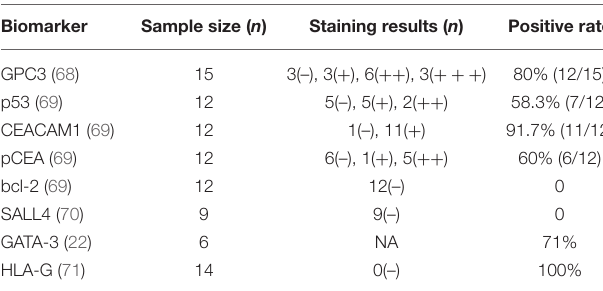
TABLE 4 | Differential diagnosis and potential diagnostic biomarkers of